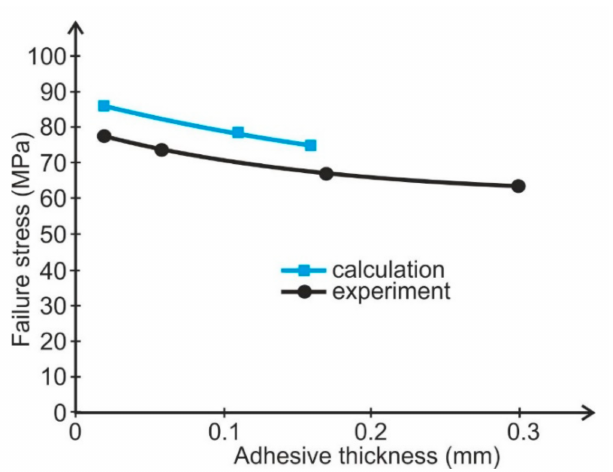
Figure 10. Comparison of Epidian 57/Z1 adhesive failure stresses determined experimentally using butt specimens with FEM calculated failure stresses for lap joints.